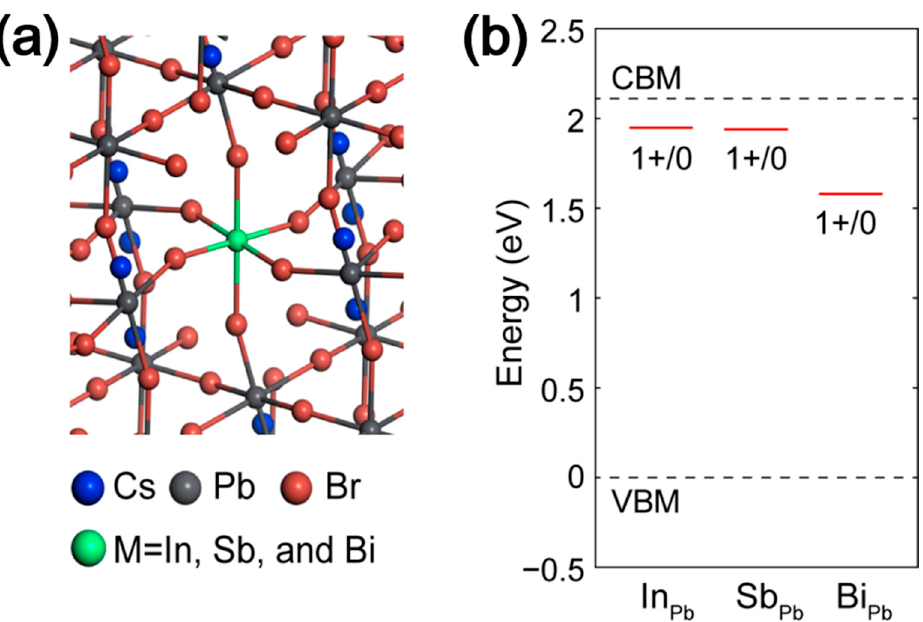
Figure 4. ( a ) Atomic structure simulation of CsPbBr 3 perovskite QDs with substituted defects. ( b ) The position of the thermodynamic defect level of for In Pb , Sb Pb , and Bi Pb in order.